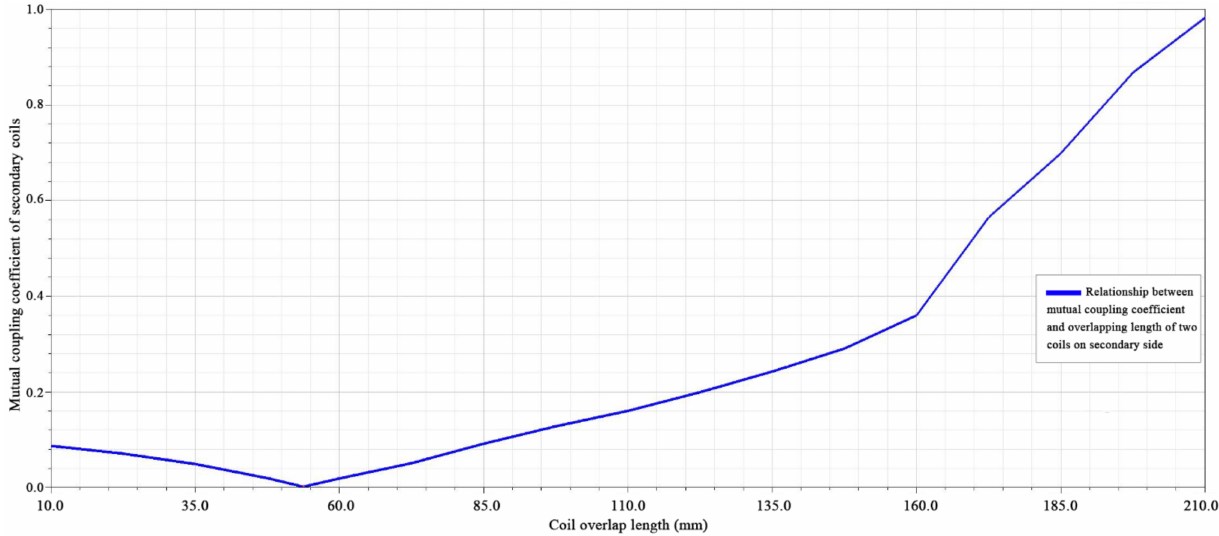
Figure 21. Relationship curve between the coupling coefficient and the coil overlap